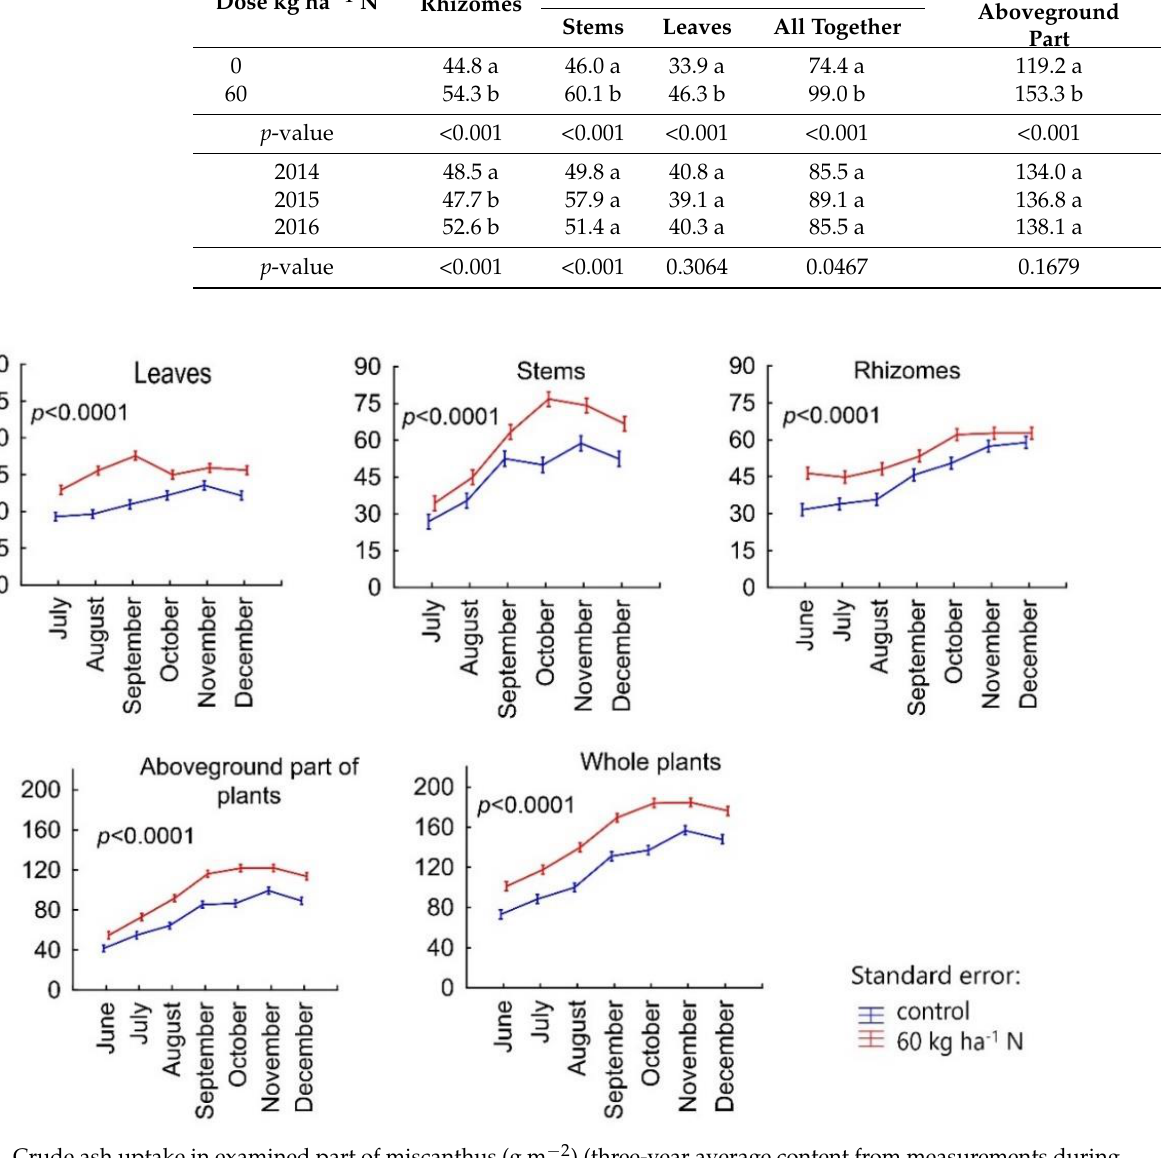
Figure 3. Crude ash uptake in examined part of miscanthus (g m − 2 ) (three-year average content from measurements during the growing season every 30 days).